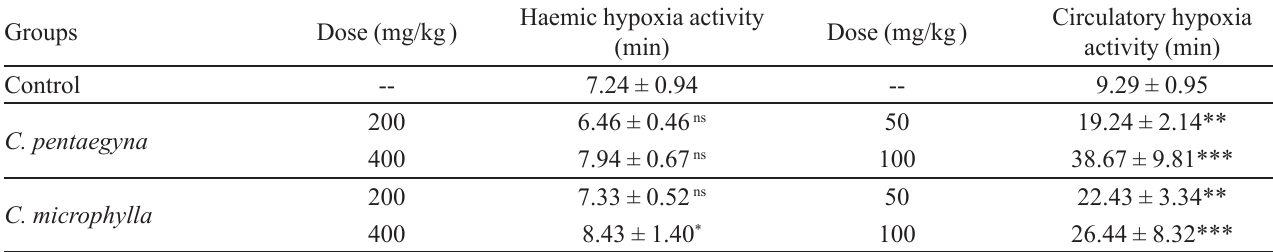
TABLE I - Antihypoxic activities of C. pentaegyna and C. microphylla in haemic and circulatory hypoxia in mice